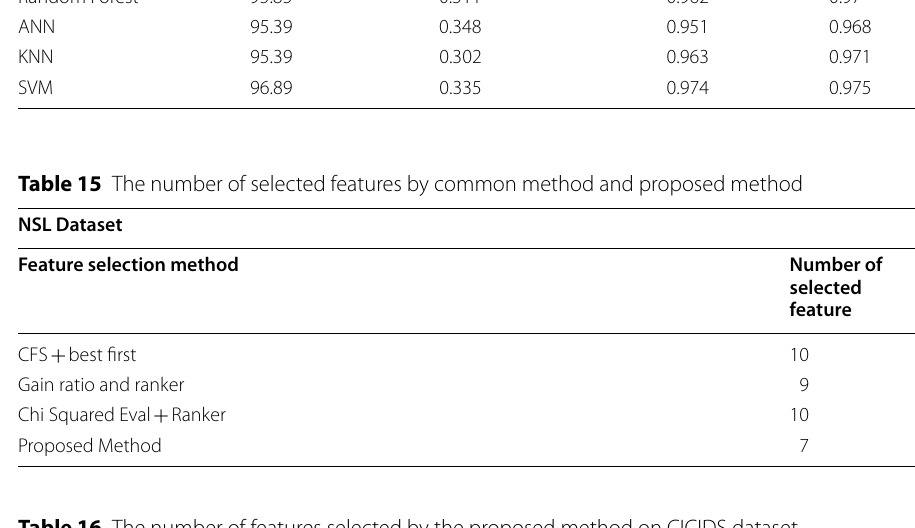
Table 16 The number of features selected by the proposed method on CICIDS dataset Merits